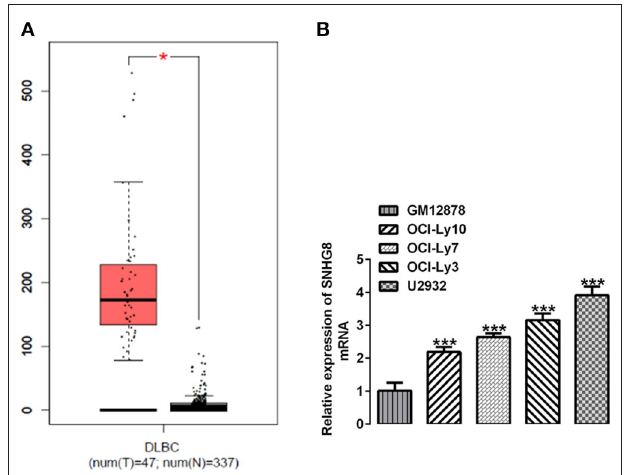
FIGURE 1 | SNHG8 is upregulated in diffuse large B-cell lymphoma (DLBCL). (A) The levels of SNHG8 in DLBCL patients (left, red) and normal healthy individuals (right, black) and data from the Gene Expression Profiling Interactive Analysis (GEPIA) database. * p < 0.05. (B) The mRNA expression of SNHG8 in normal human B-lymphocytes, GM12878, and human DLBCL cell lines including OCI-Ly10, OCI-Ly7, OCI-Ly3, and U2932. *** p < 0.001 vs. GM12878.